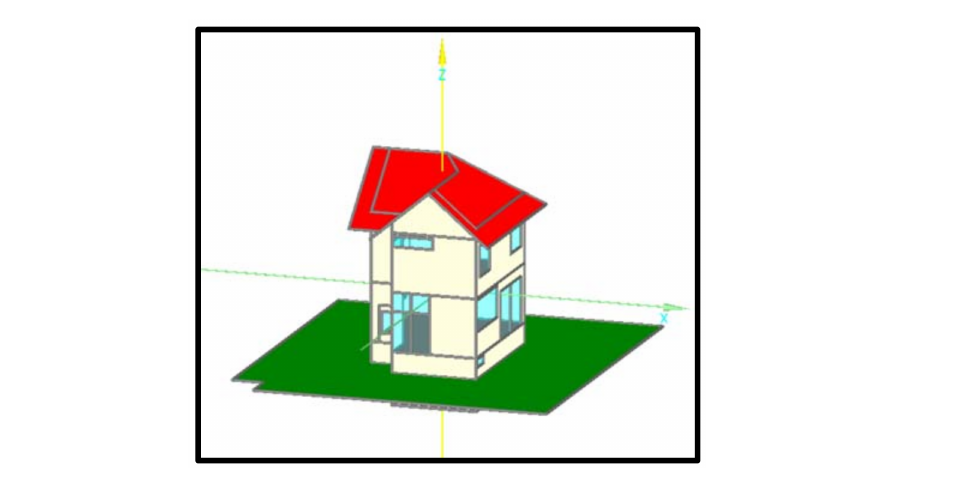
Figure 2. A 3D view of the three-story house showing the three levels and configuration of existing components of exterior walls, roof, windows, and other openings created by WUFI.